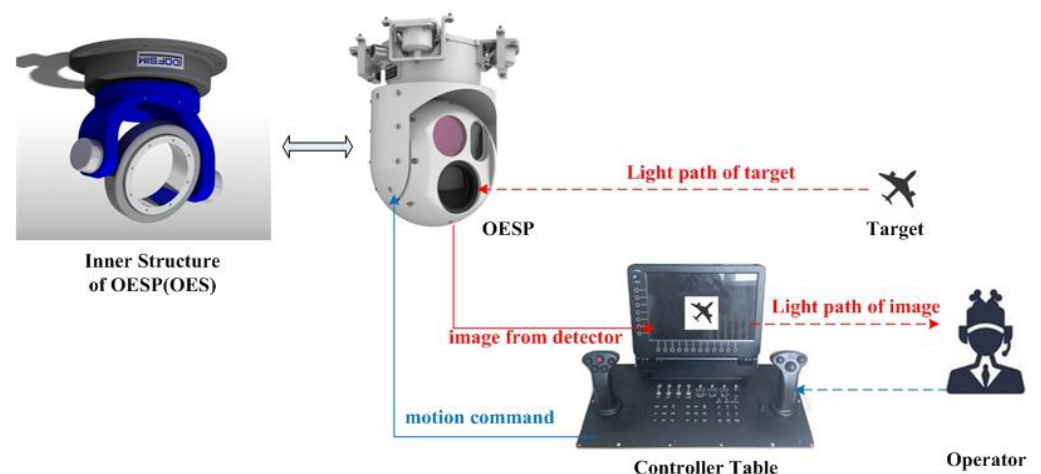
Figure 1. Principle of the opto-electric servo platform (OESP).